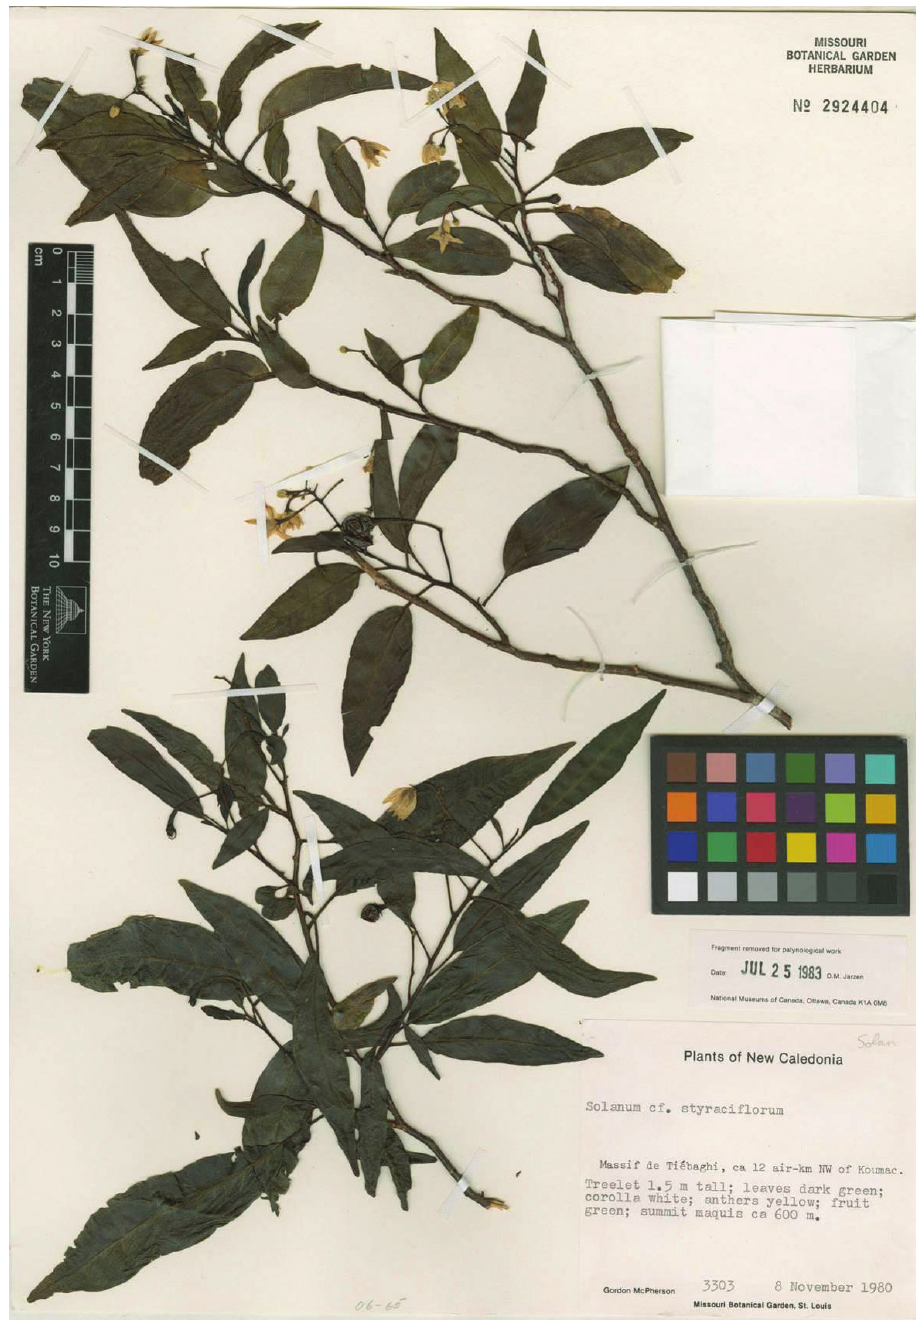
Figure 11. Solanum semisucculentum D.McClelland (isotype McPherson 3303 , MO [acc. # 2924404, barcode MO-2282964]). Reproduced with